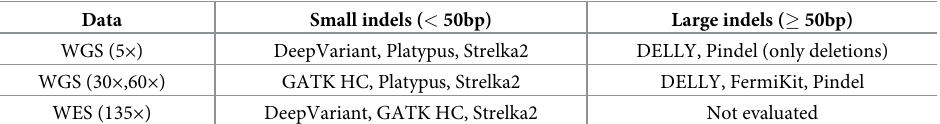
Table 4. Recommended variant calling tools for different sized indels and sequencing